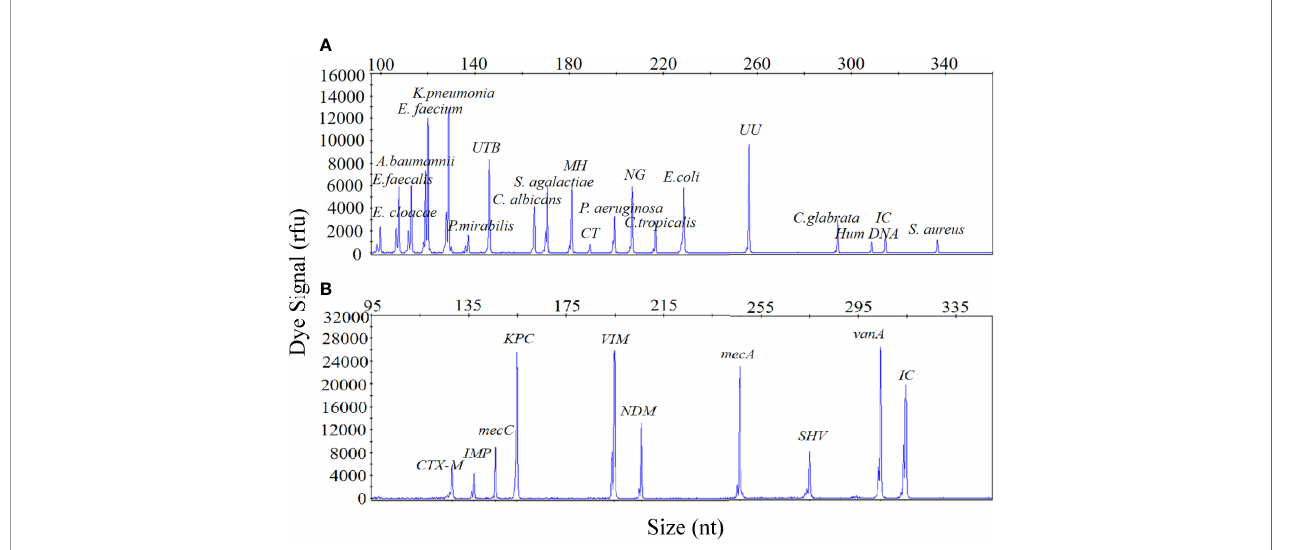
FIGURE 2 | The optimized UTI-HMGS assay maintained high levels of sensitivity for the simultaneous detection of all speci fi c pathogens and control genes tested in the two detection assays. (A) The detection limits of the UTI-HMGS assay when detecting uropathogens were determined by amplifying ten-fold diluted plasmids containing equal amounts of 18 uropathogens and 2 quality control templates at a concentration of 100 copies/µL. Note that the uropathogen-de fi ning DNA targets all generated speci fi c peaks (from left to right: E. cloacae, E. faecalis , A. baumannii , E. faecium , K. pneumoniae , P. mirabilis , UTB, C. albicans , S. agalactiae , MH, CT, C. tropicalis , E. coli , UU, C. glabrata and S. aureus ). The quality controls (Hum DNA and IC) produced speci fi c peaks at 308 bp and 315 bp, respectively. (B) The detection limit of the UTI-HMGS assay for the resistance genes assay was determined by amplifying tenfold diluted plasmids containing equal amounts of the